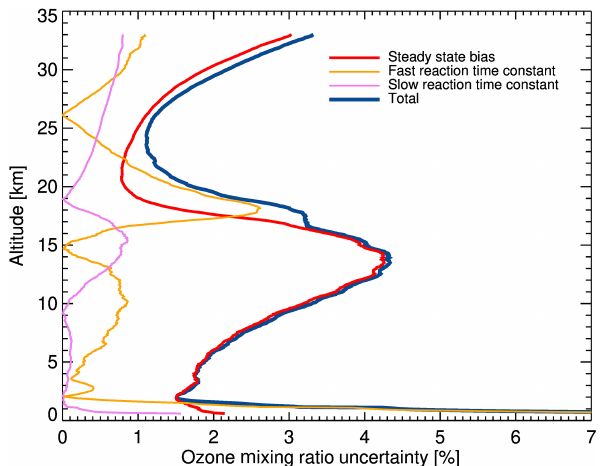
Figure 14. Contributions to the total uncertainty introduced by the correction shown in Fig.